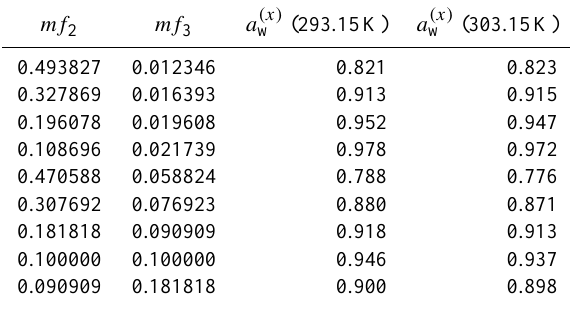
Table A11. Bulk water activity measurements of the system wa- ter (1)+malonic acid (2)+NaCl (3) at T = 293 . 15 and 303 . 15K. Aqueous solution compositions are given in mass fractions ( mf j ).